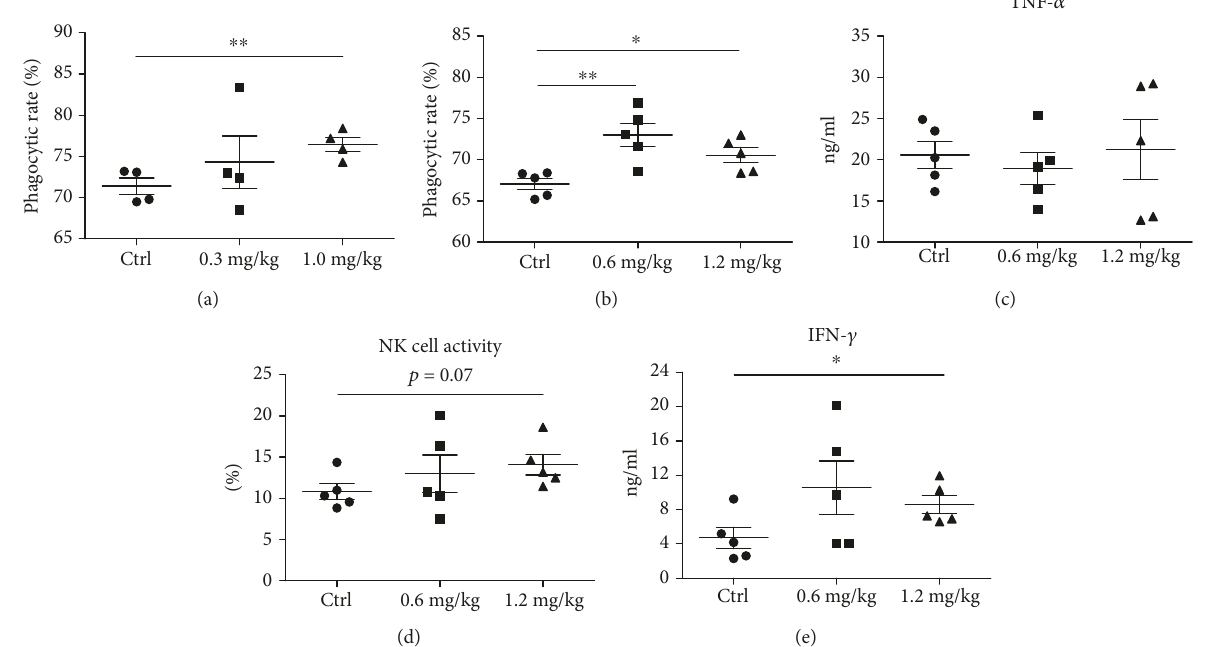
Figure 5: E ff ects of sublancin on the function of peritoneal cells and splenocytes in vivo. Sublancin enhanced the phagocytic activity of peritoneal macrophages ex vivo (a and b). Four- to six-week-old female BALB/c mice were separated into three groups: control, sublancin low-dose group (0.3mg/kg or 0.6mg/kg), and sublancin high-dose group (1.0mg/kg or 1.2mg/kg). The mice were orally administered with sublancin for 28 days (0.3 mg/kg and 1.0mg/kg) or 14 days (0.6 mg/kg and 1.2mg/kg). Mice in the control group were given distilled water by gavage. Peritoneal macrophages were harvested and incubated with fl uorescent microspheres for the determination of phagocytic activity. (c) Comparison of TNF- α production in peritoneal macrophages stimulated with LPS (1 μ g/ml). (d) Sublancin (1.2mg/kg) promoted a weak level of NK cell activity. Splenocytes were isolated from mice and cocultured with Yac-1 cells by a ratio (splenocytes :Yac-1) of 75 :1 for 4 h. Cytotoxicity was measured by the lactate dehydrogenase assay. (e) Comparison of IFN- γ level in activated splenic T cells (2 μ g/ml anti-CD3 and 1 μ g/ml anti-CD28 antibodies). Data shown are means ± SEM and derived from 4 to 5 mice in each group. Signi fi cant di ff erence with the control group were designated as ∗ P < 0 05 and ∗∗ P < 0 01